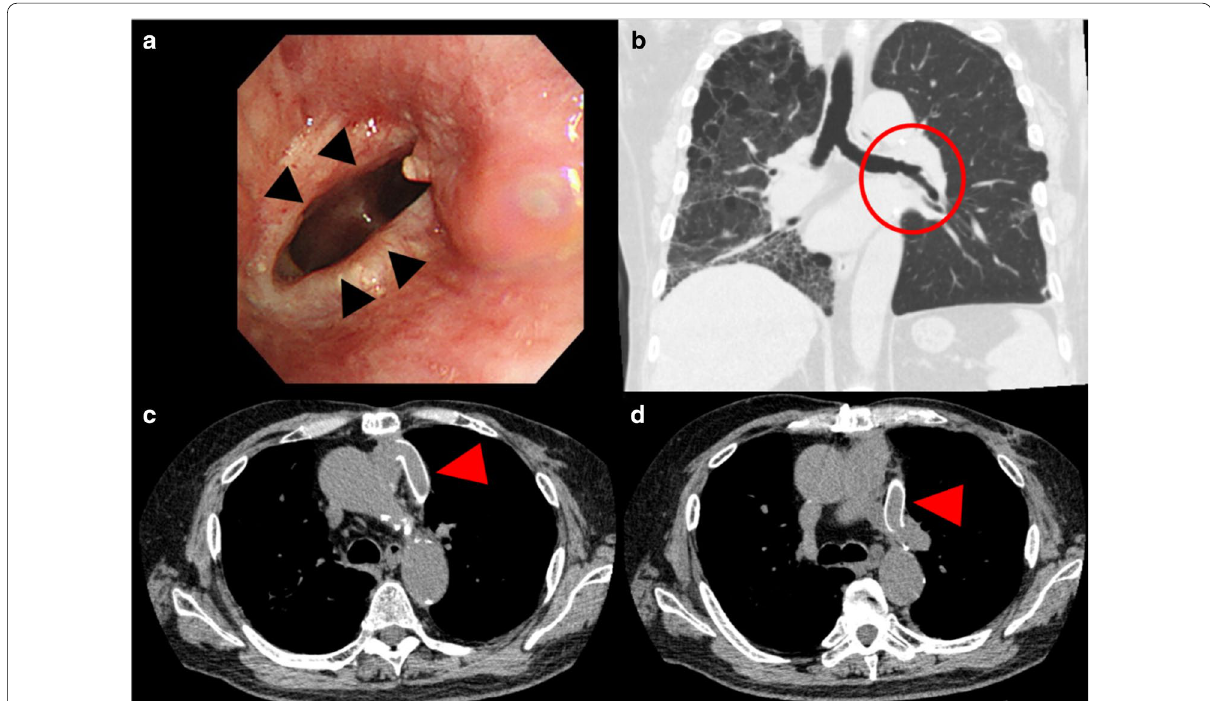
Fig. 4 Postoperative bronchoscopic image and chest computed tomography scans 10 months after reconstructive surgery. a Anastomosis of the bronchus (black arrowheads). b Coronal section of a computed tomography scan showing the patent’s left main bronchus (red circle). c , d A vascular graft (red arrowhead) extending from the pulmonary artery trunk to the left main pulmonary